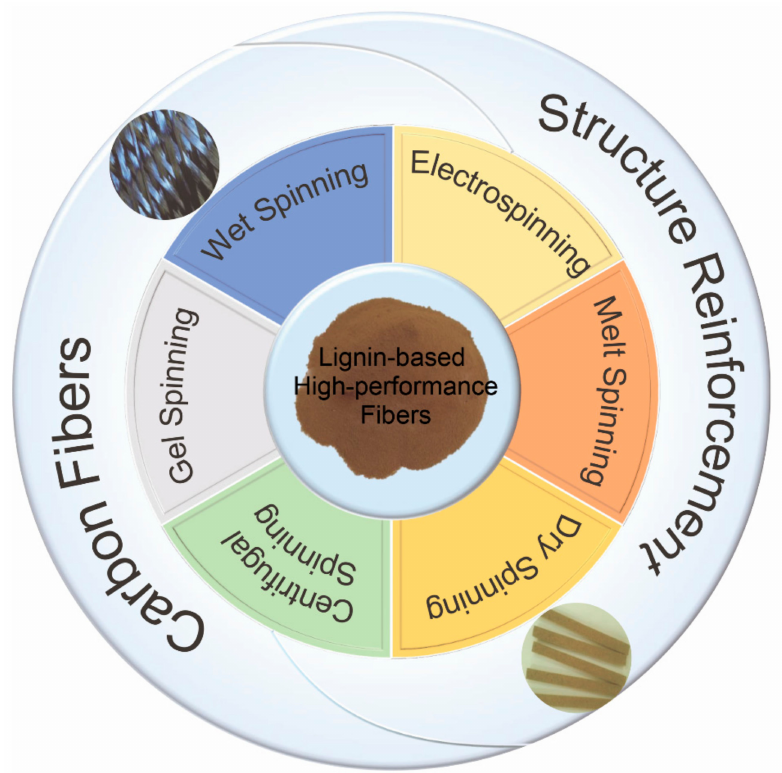
Figure 1. Diagram illustrating overview of lignin-based high-performance fibers for carbon fiber and structure reinforcement of composite (reproduced from an open-access article [45]) applications by textile spinning techniques in this